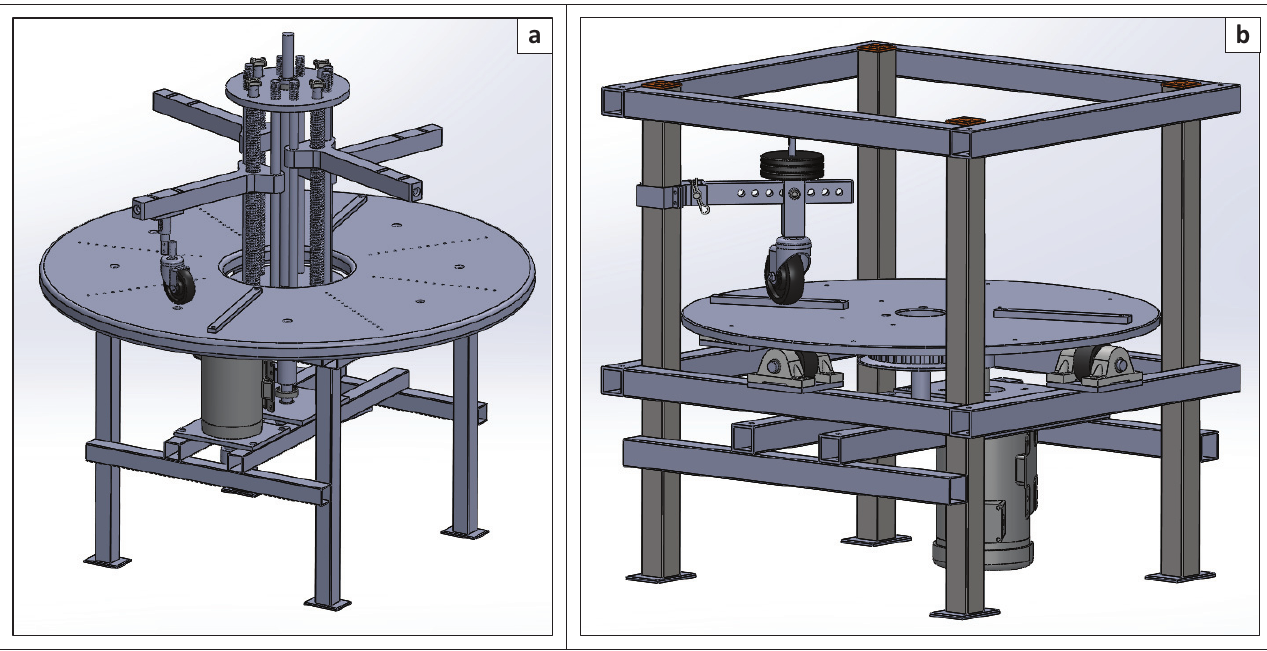
FIGURE 6: Caster assembly test design concepts #4 (left) and #5